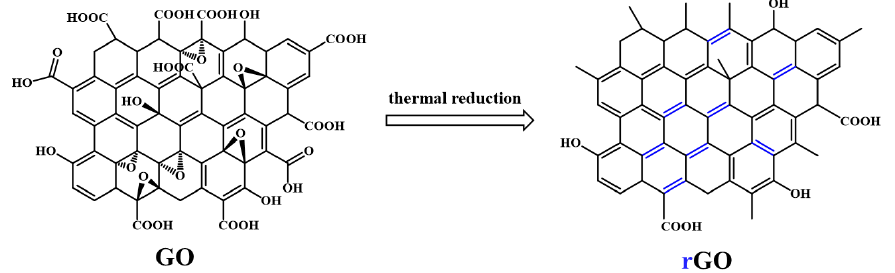
Figure 2. GO is thermally reduced to rGO at high temperature (The blue bonds represent restored conjugated bonds through high-temperature reduction).